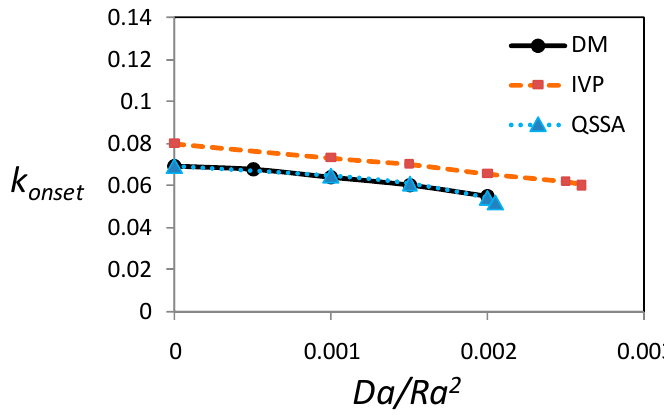
Figure 9. The most unstable wave number at the onset of instability (dimensionless) as a function of Da / Ra 2 for a precipitating reaction, predicted using the dominant mode analysis (DM), the initial-value problem approach (IVP), and the quasi-steady state assumption (QSSA).